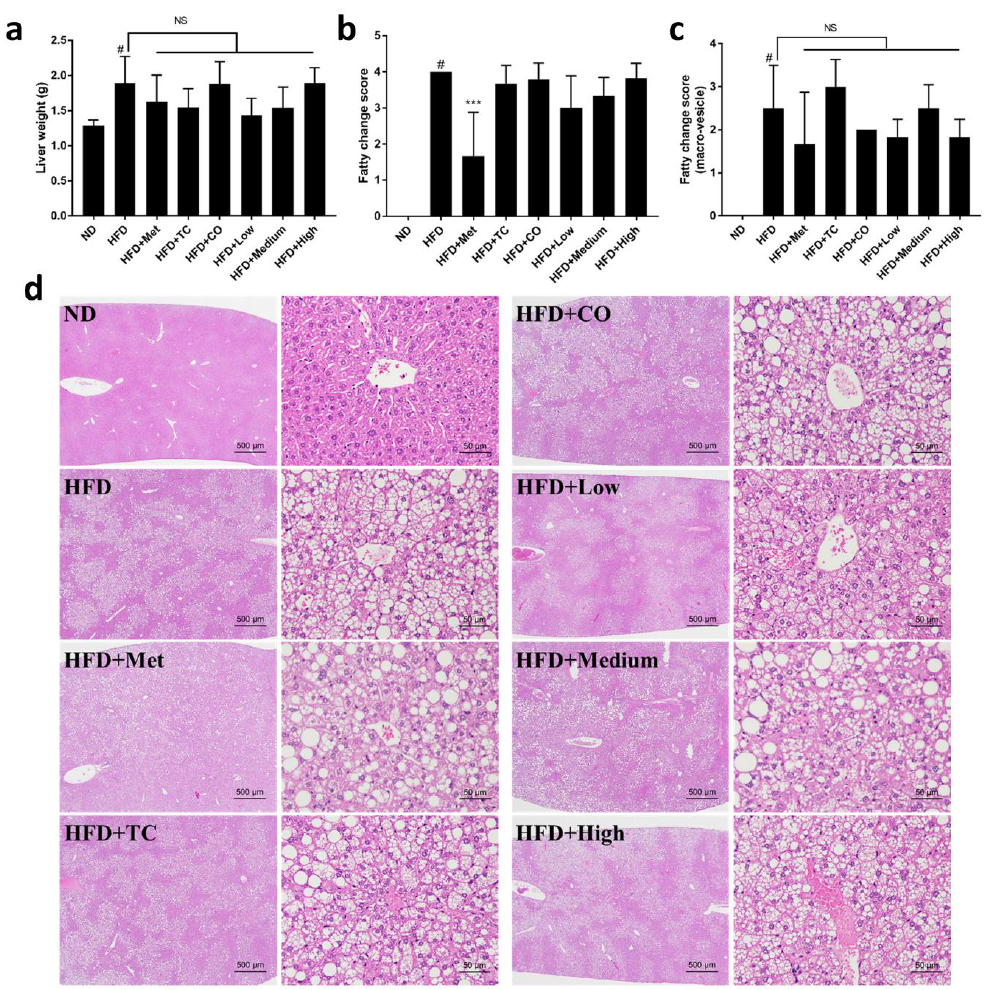
Figure 2. Effects of CO/TC formulations on hepatic steatosis (n = 6). ( a ) Liver weight. ( b ) Fatty change score of the livers. ( c ) Fatty change score with macro-vesicles of the livers. ( d ) Liver microsections stained with H&E. Data are reported as mean ± SD and analyzed by one-way ANOVA with Tukey post-hoc test. # p < 0.05 was considered significant for ND vs. HFD. *** p < 0.001 vs. HFD group. NS, represents no significance difference ( p > 0.05).